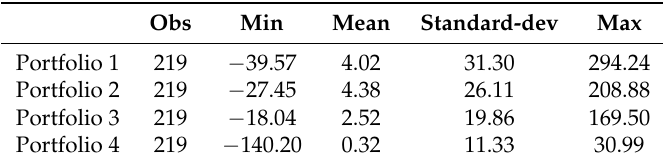
Table 1. Descriptive statistics of